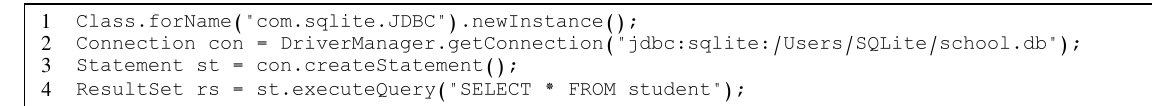
Fig. 1. An example of database connection through